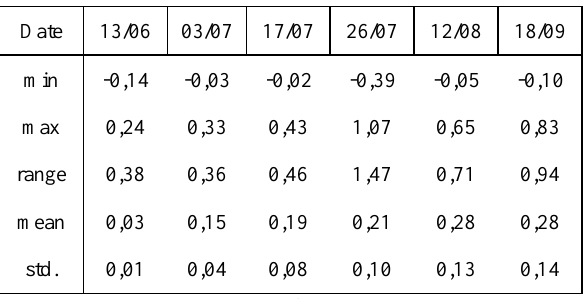
Table 1: Descriptive statistics of derived plant heights in meter (std. = standard deviation)